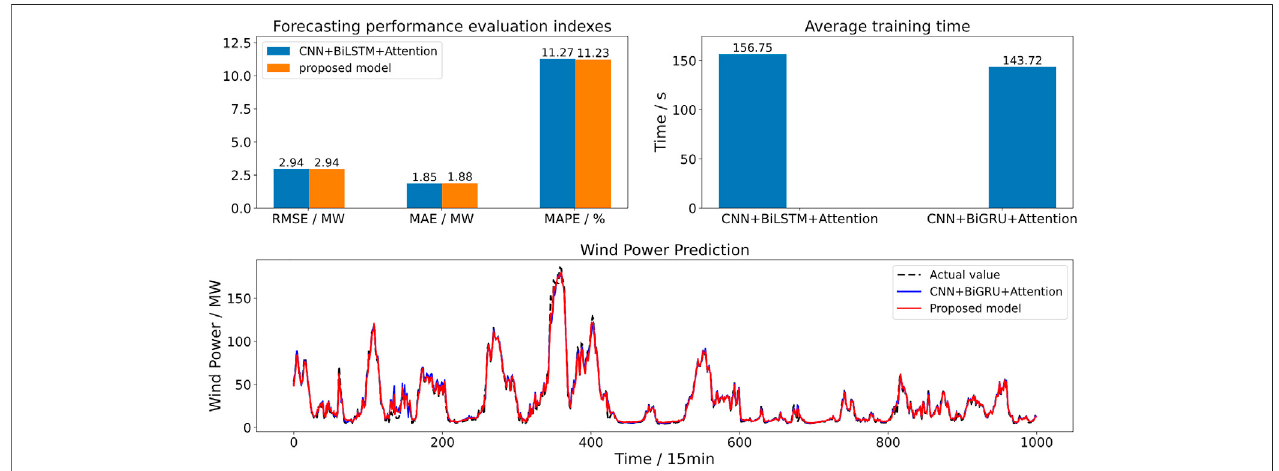
FIGURE 8 | The prediction results, prediction error-index, and model training time of the model